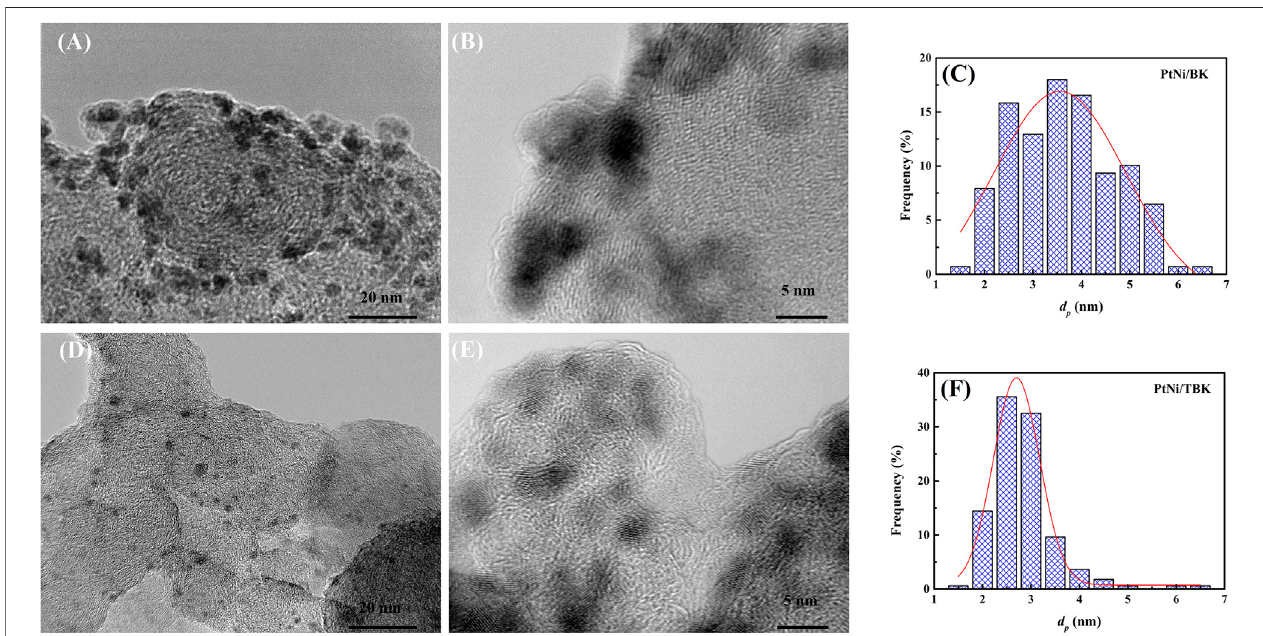
FIGURE4| RepresentativeTEMandHR-TEMimagesandthecorrespondingparticlesizedistributionhistogramsofthebimetallicPtNinanoparticlessupportedon BK (A – C) and TBK (D – F) biocarbons.